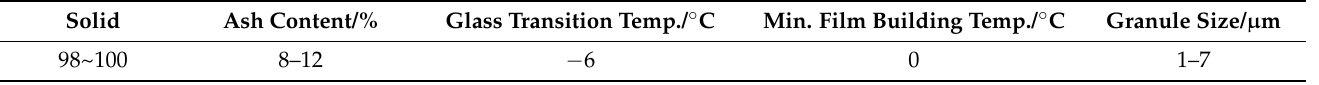
Table 3. The detailed properties of EVA used in this